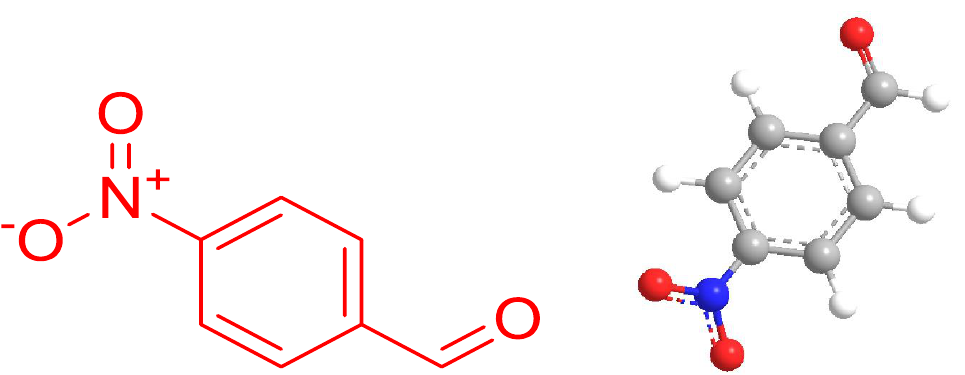
Figure 1. Structure of cyclodextrin molecules.